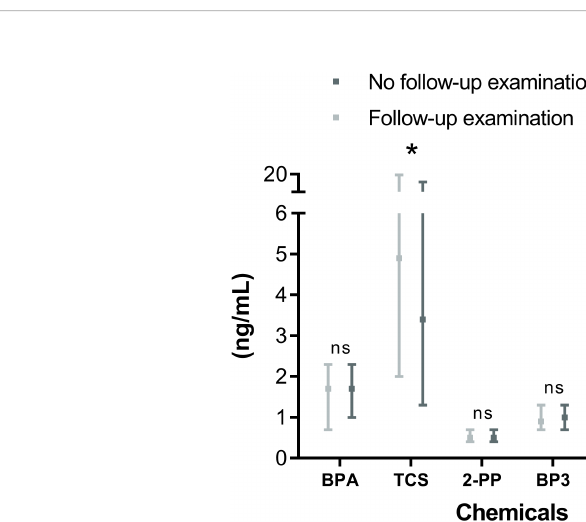
TABLE 2 Basic characteristics of the study population. Follow-up of son No follow-up of son